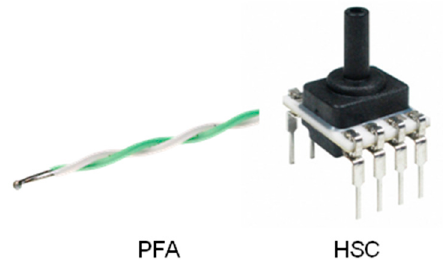
Figure 3. Thermocouple PFA (perfluoroalkoxy) K-type [29] and HSC (High-accuracy Silicon Ceramic) gauge pressure sensor (amplified version) [30].